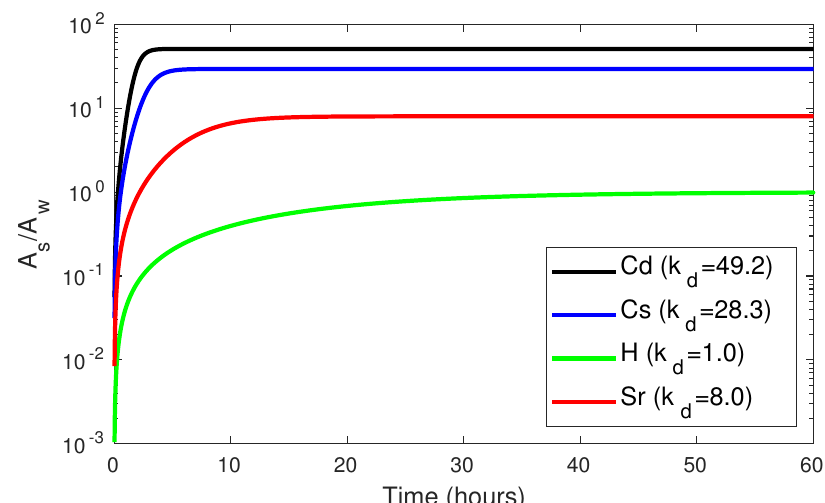
Figure 3. Ratio between tracer fractions in sediment and water for several